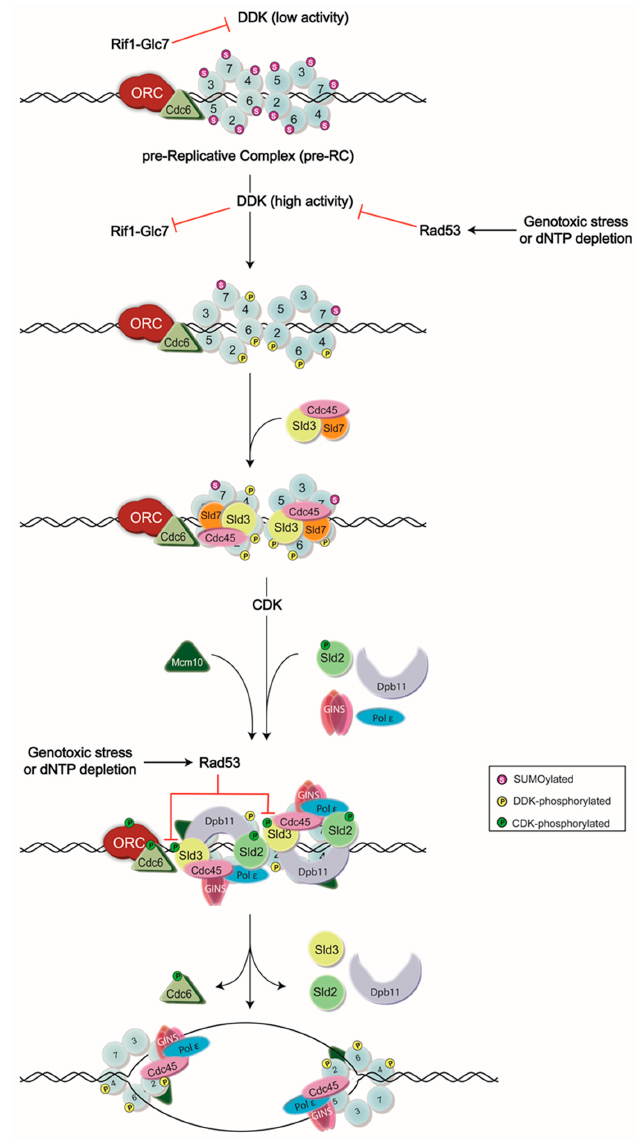
Figure 1. Model of DNA replication initiation. DNA replication is initiated by the assembly of the pre-Replicative Complex (pre-RC) at G1 phase, which is then followed by a series of phosphorylation events carried out by Dbf4-dependent kinase (DDK) and cyclin-dependent kinase (CDK) to generate the active form of the CMG (Cdc45-Mcm2-7-go-ichi-ni-san(GINS)) helicase. Normally, DDK activity is low until the end of G1 phase, as Dbf4—the regulatory subunit of DDK—is degraded in an anaphase promoting complex (APC)-dependent manner [12–15]. However, some Dbf4 that has escaped this process can provide residual DDK activity, contributing to potential premature Mcm2-7 complex phosphorylation. To avoid this, Rif1 recruits the protein phosphatase Glc7 to dephosphorylate the DDK targets. High activity of DDK in late G1 phase is proposed as a mechanism to inhibit Rif1-Glc7 activity [16,17]. DDK activity is also inhibited by the S-phase checkpoint kinase, Rad53, during exposure to genotoxic agents or dNTP depletion. Rad53 binds to and phosphorylates Dbf4 to remove DDK from chromatin and prevent subsequent origin firing [2–6]. Rad53 also phosphorylates an essential target of CDK, Sld3, to ensure the inhibition of DNA replication during replication stress [3,4], ORC: Origin Recognition